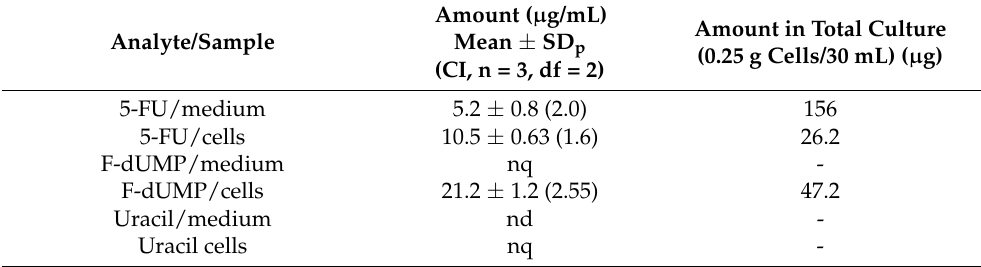
Table 3. Levels of 5-FU, FdUMP, and uracil in cells and in the culture medium following admin- istration of 50 µ g/mL 5-FU for 96 h. The estimated values are presented as mean ± SD p (n = 3) in the first column, and the values in parentheses indicate the confidence interval (CI) at a = 0.025, df = 2, and t value = 4.303. Values in the second column are estimated by multiplying the average appearing in the first column with either the total weight of the cells or the total volume of the culture, as